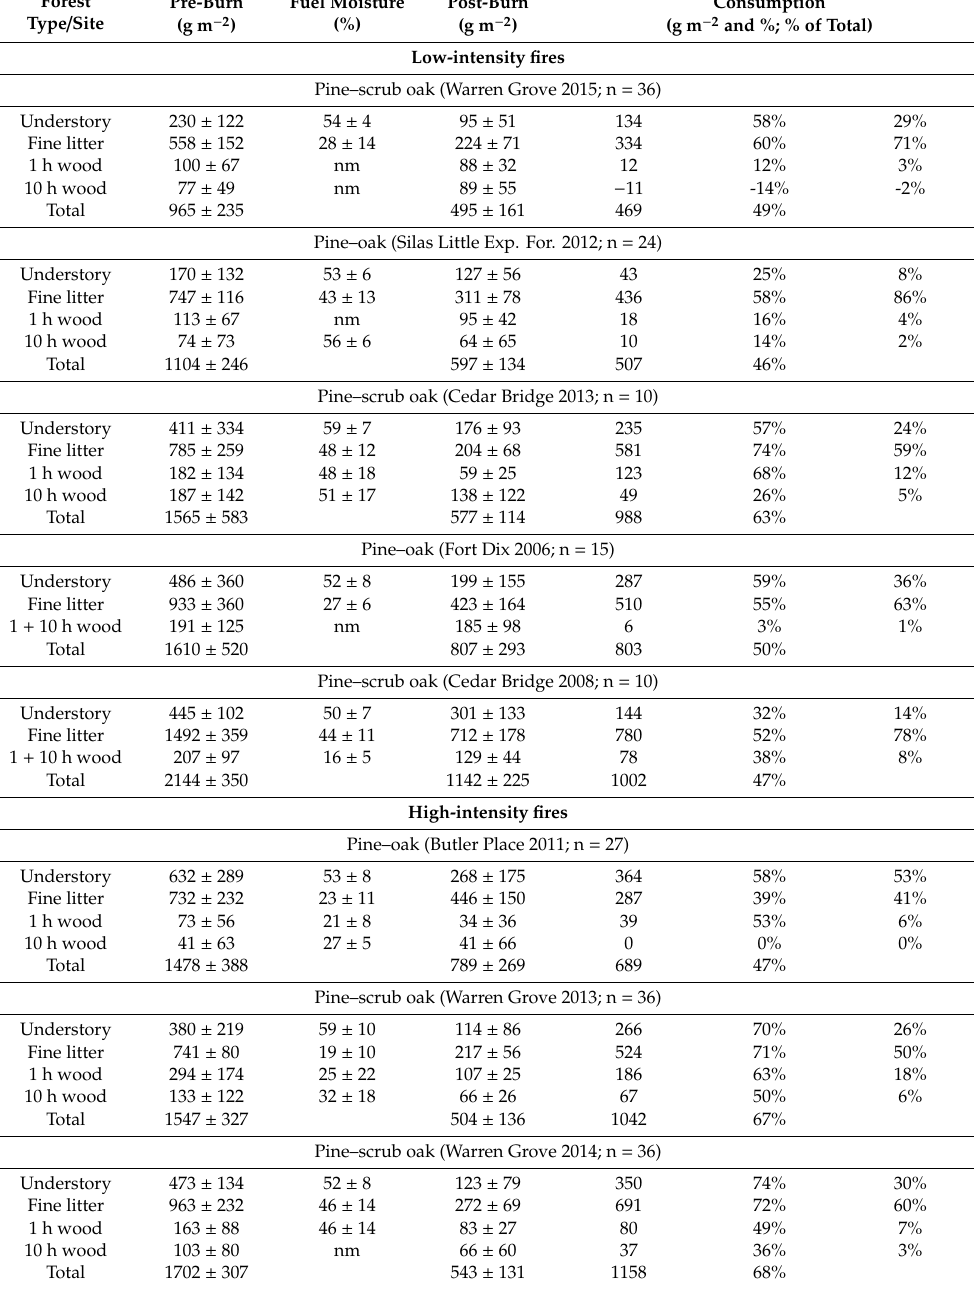
Table A1. Understory and forest floor fuel loading measured pre- and post-burn, fuel moisture content sampled during each burn, estimated consumption, percent estimated consumption, and the contribution of individual types to total fuel consumption for eight prescribed fires conducted in the Pinelands National Reserve. Presentation order follows initial total surface and understory fuel loading from lowest to highest within category of burn intensity. Values are the means ± 1 SD, and “nm” is not